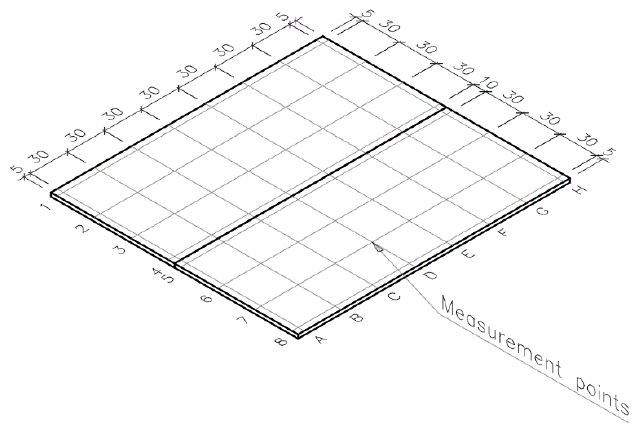
Figure 5. Control grid created in the samples.